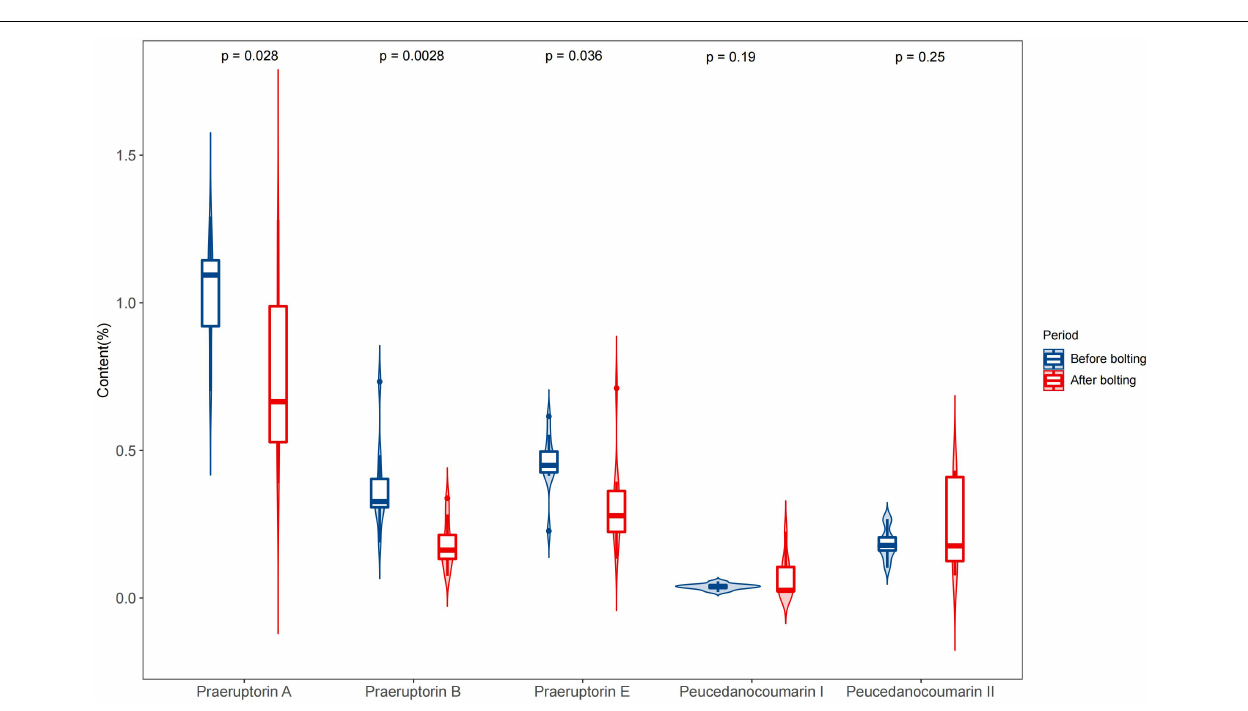
FIGURE 4 | Determination of five coumarins of the unbolted and bolted P. praeruptorum . Ten batches of experiments were repeated for each group. The content of each coumarin was calculated as the mean plus standard error. A significant analysis was carried out on the content of coumarins in unbolted and bolted P. praeruptorum . " p -value < 0.05" means there is a significant